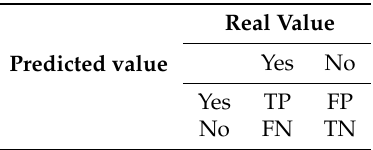
Table 2. Binary confusion